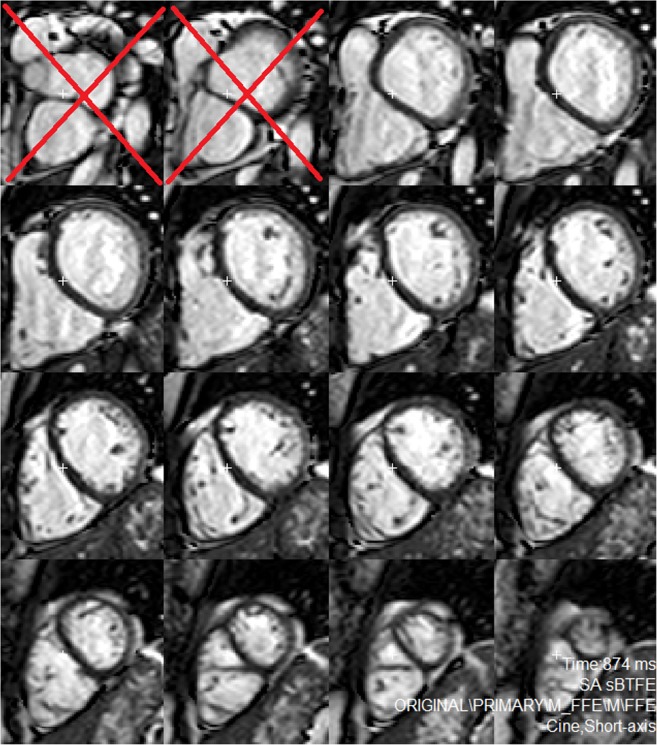
Example of segmentation of the shortaxis slices using segment.Slices that did not include >50% of the circumference of the myocardium were excluded from segmentation.